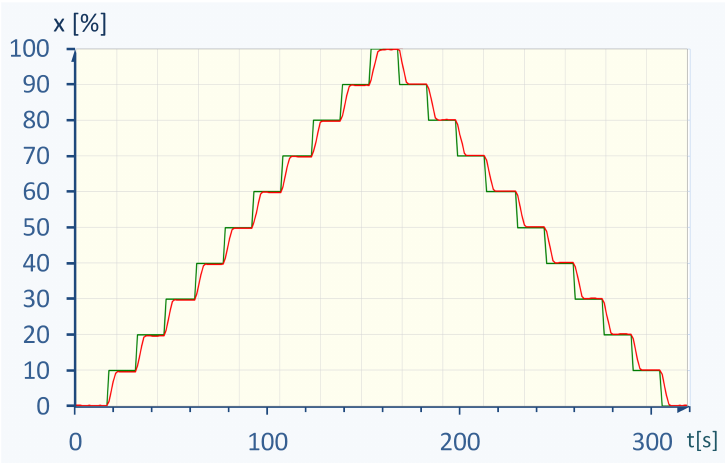
Figure 19. Illustration of the autotuner quality on the stepwise response of normal-action unloaded actuator type Masoneilan 37-13 under nominal operating conditions. The applied nominal bench range set is [20–100 kPa]. The nominal supply pressure, p s , is 140 kPa.